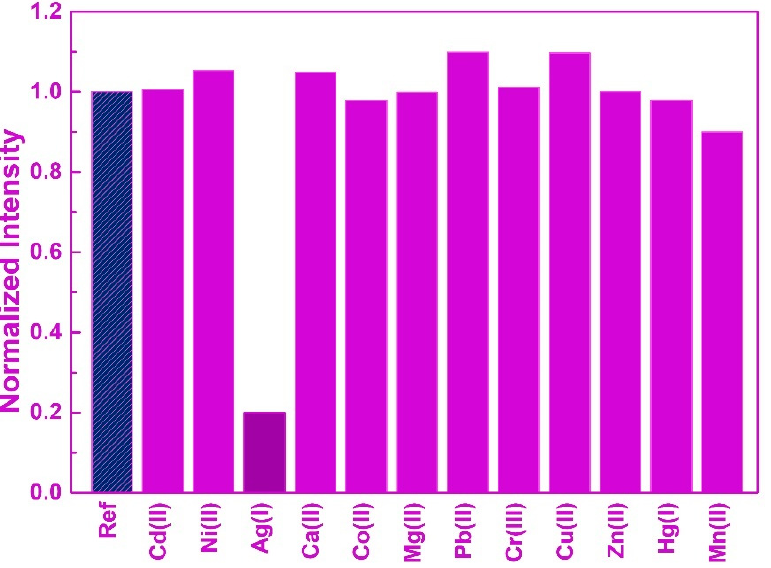
Figure 6. Normalized fluorescence intensity ratio of the various metal N-CQDs water solutions (metal concentration = 18 nM).